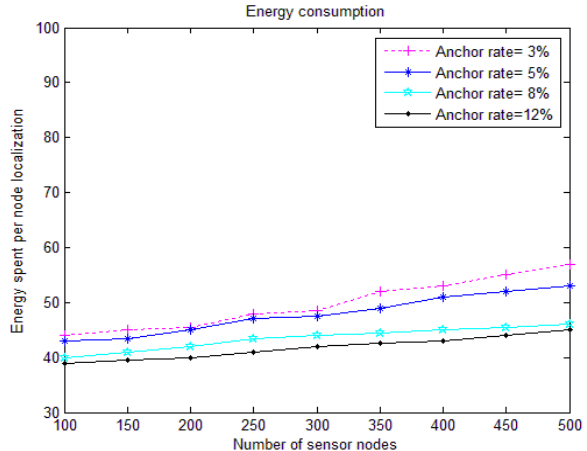
Figure 9. Energy consumption per node for